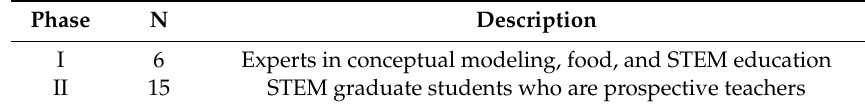
Table 2. Research